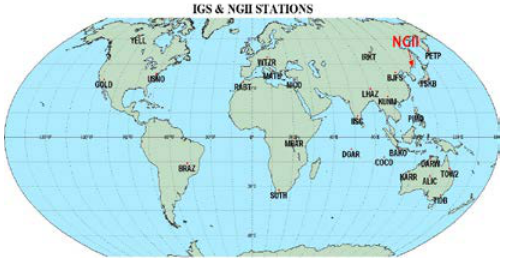
Figure 4. Selected IGS station and location of NGII GPS network in Korean